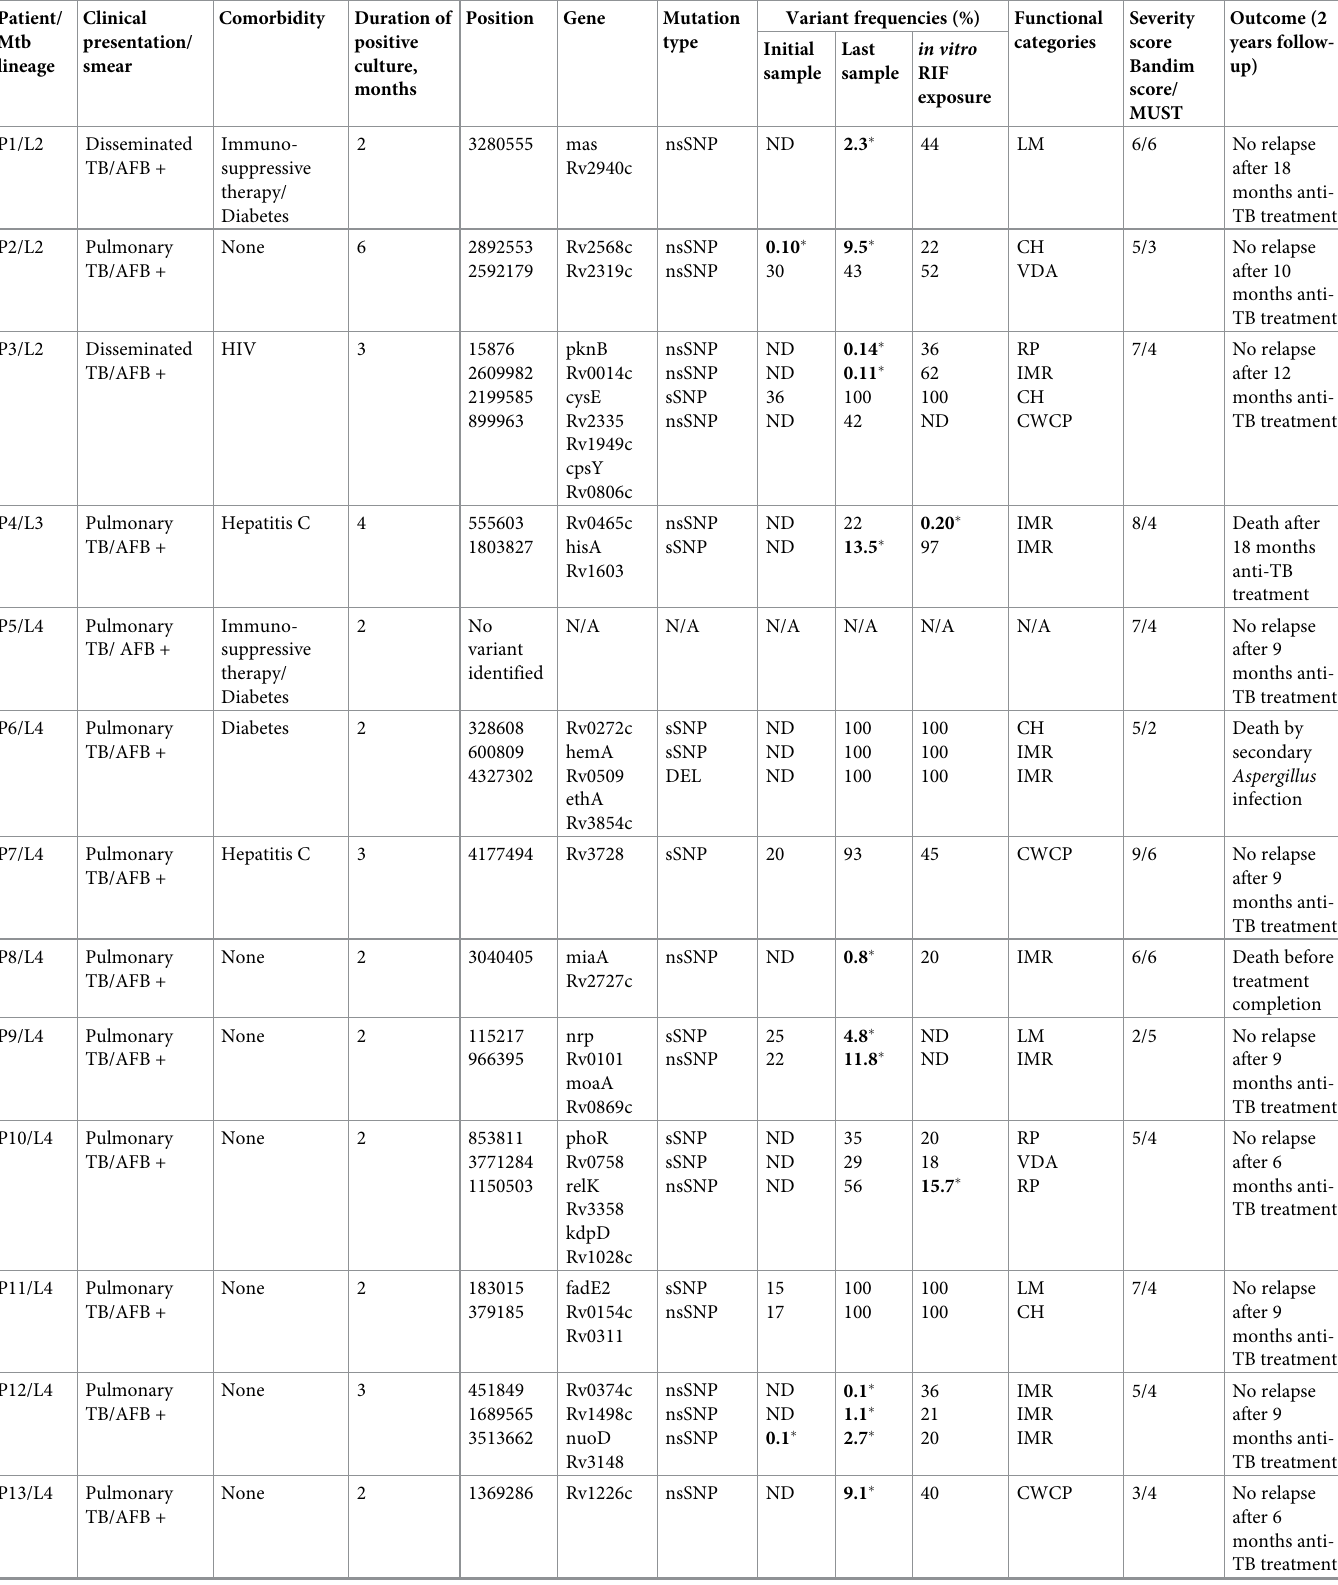
Table 1. Mtb variants identified emerging from persistent clinical isolates and after 4 weeks of exposure to 1x MIC RIF in vitro